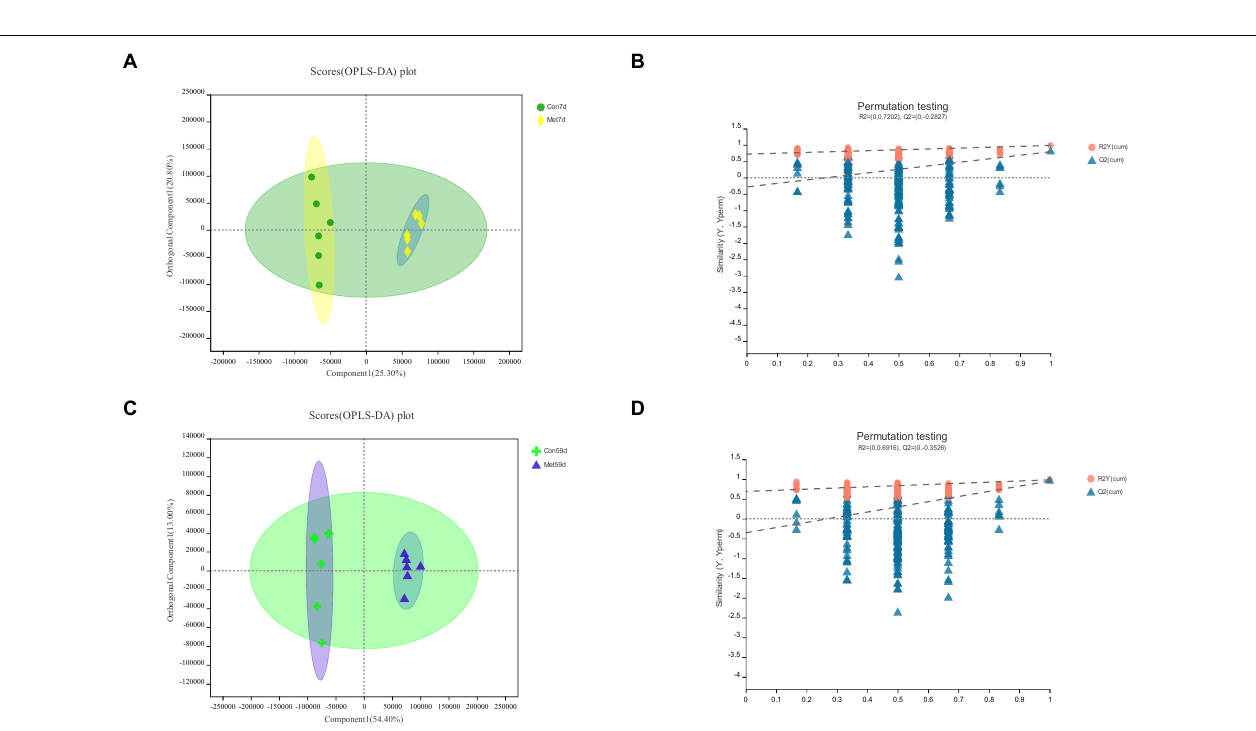
FIGURE 3 | In Met vs. Con, panels (A,B) for 7th day and panels (C,D) for 59th day. Panels (A,C) are OPLS-DA scores plot. Panels (B,D) are OPLA-DA permutation tests. (B) R 2 X (cum) = 0.462, R 2 Y (cum) = 0.985, Q 2 = 0.794. (D) R 2 X (cum) = 0.674, R 2 Y (cum) = 0.986, Q 2 = 0.956.